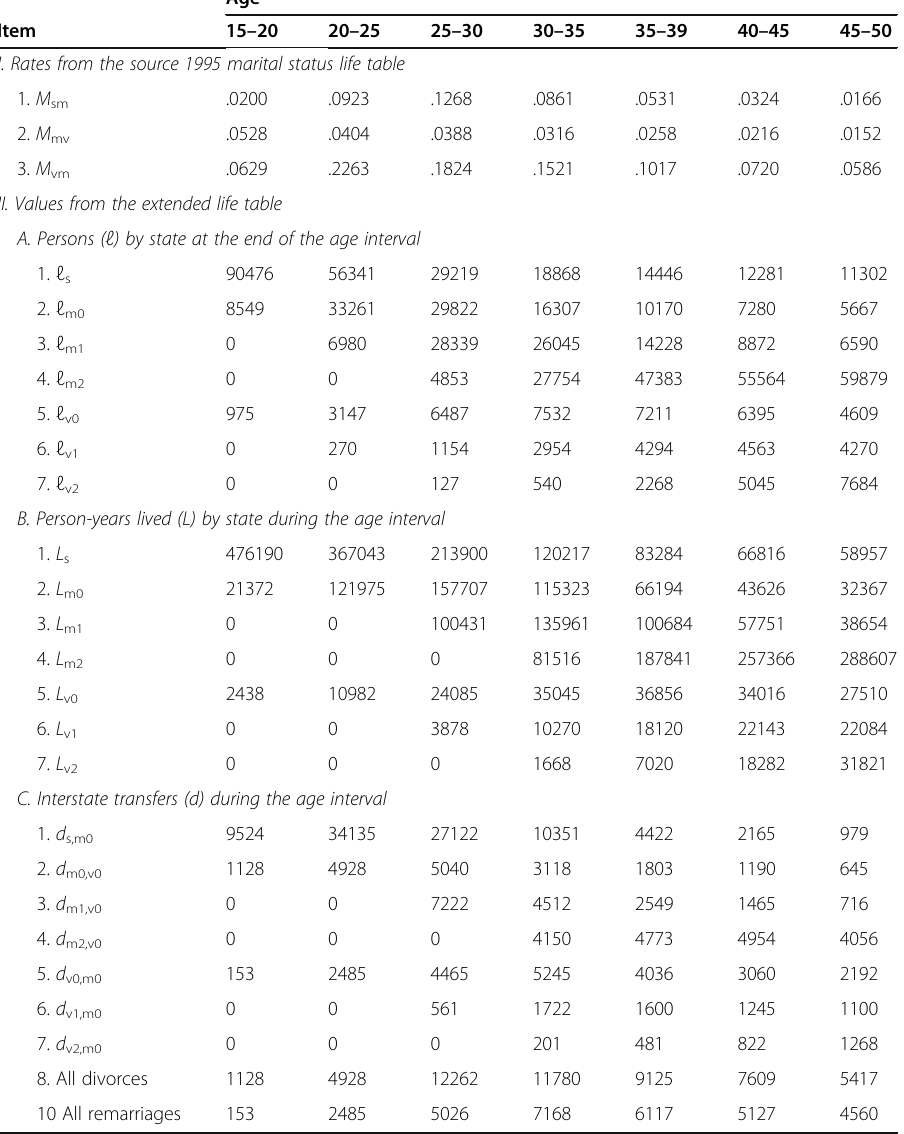
Table 3 Values from the source and extended marital status life tables for United States Females,